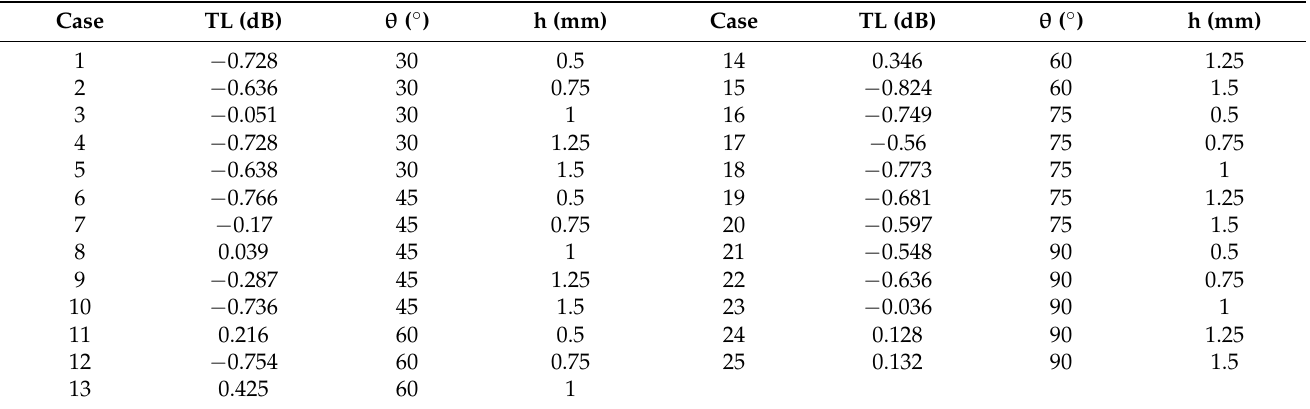
Table 3. Transmission loss at 490 Hz corresponding to different heights and top angles ( θ is top angle, h is texture height, TL is transmission